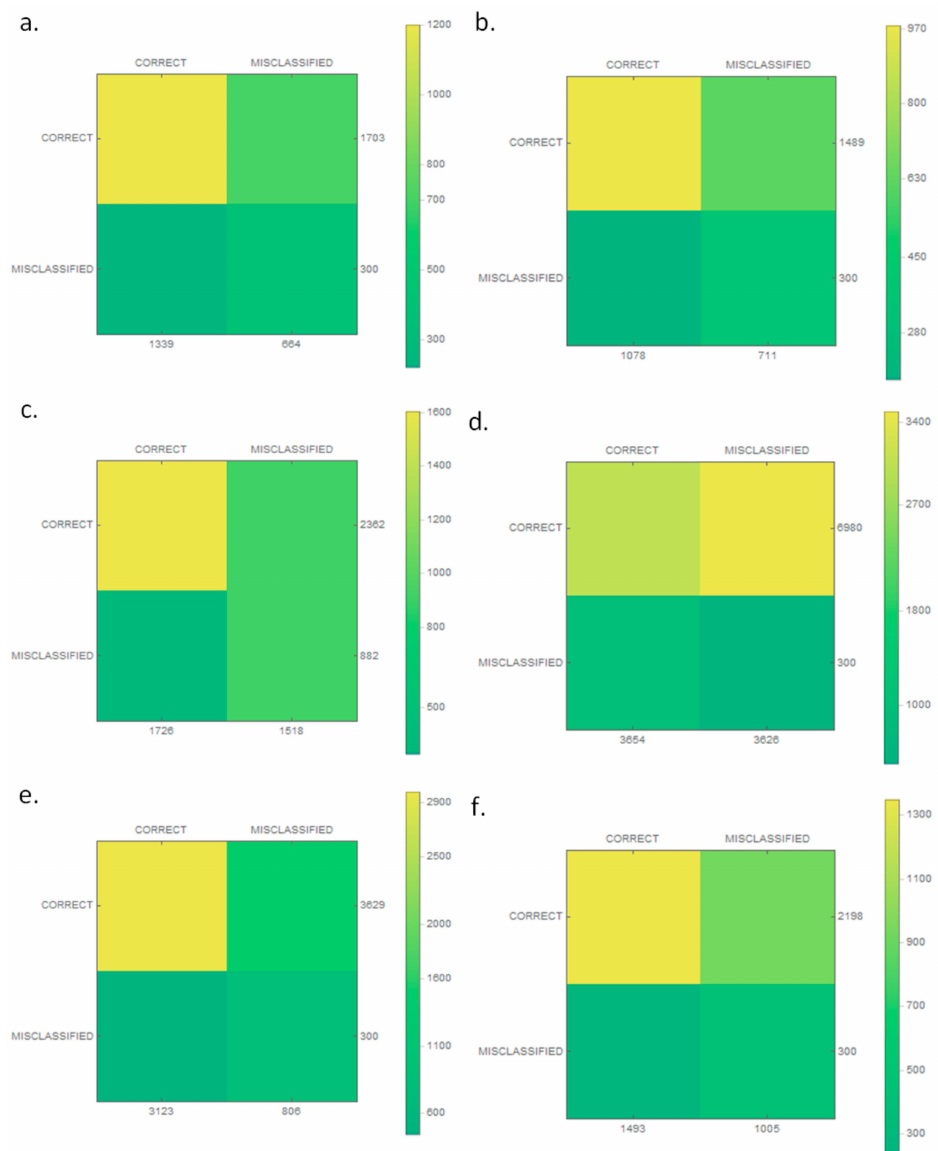
Figure 10. The confusion matrices of the classification model for each class: ( a ) barge; ( b ) yacht; ( c ) marine service; ( d ) motorboat; ( e ) passenger; and ( f )